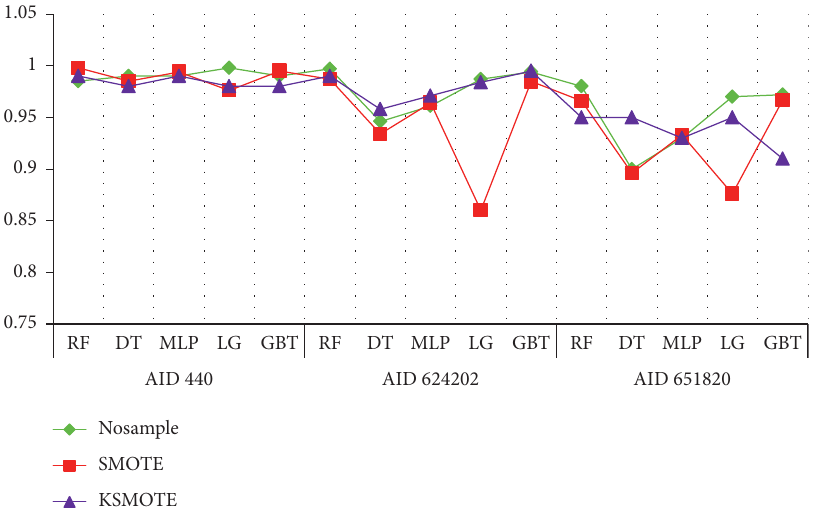
Figure 10: Specificity of all datasets for the fingerprint